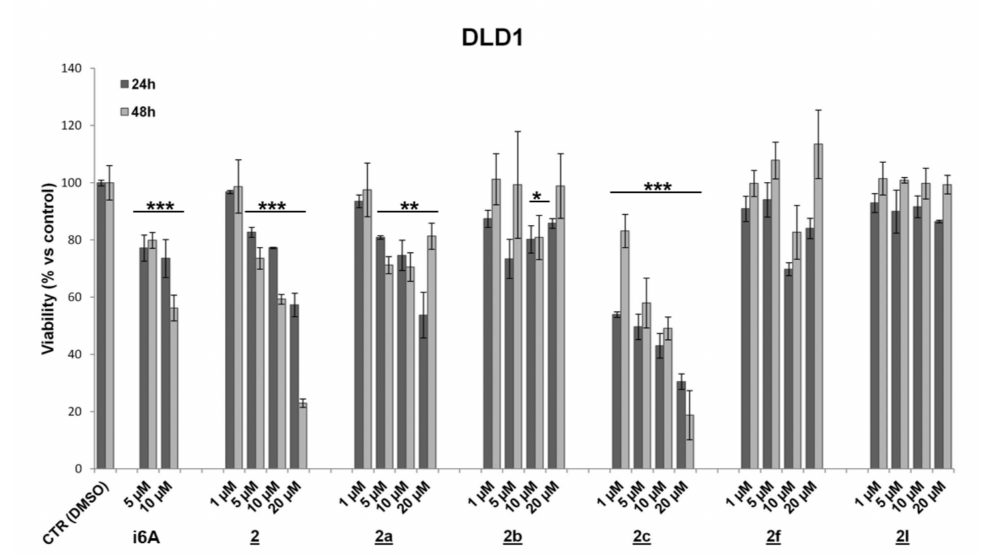
Figure 4. Effect of 2 and its analogues on DLD-1 cell viability. Values are means ± SD from three individual experiments (* p < 0.05; ** p < 0.01; *** p < 0.001; unpaired Student’s t